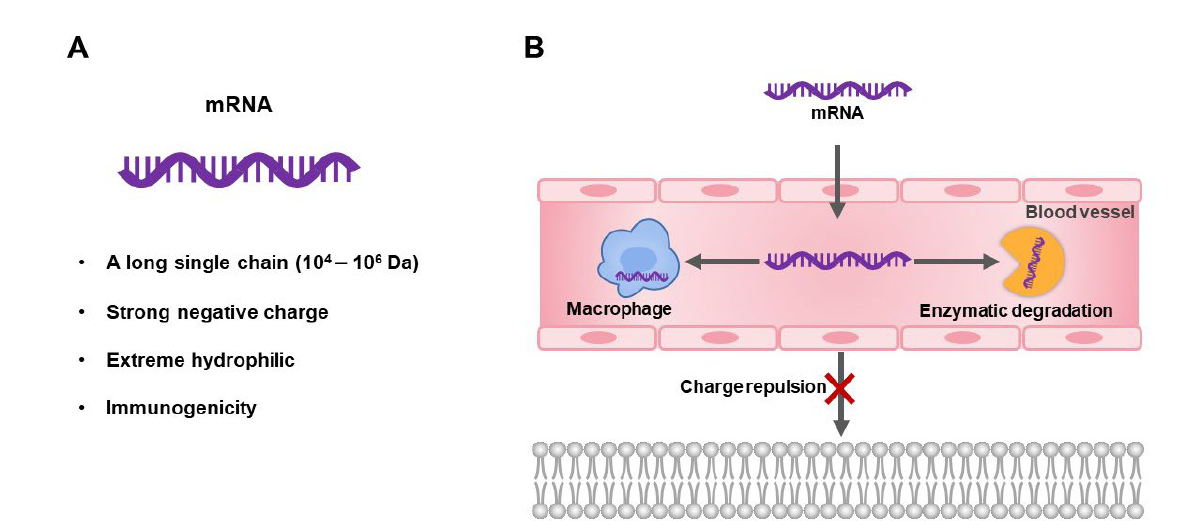
Figure 2. Structural properties and delivery challenges of mRNA therapeutics. A. The structural characteristics of mRNA; B. the schematic diagram of the intracellular and extracellular obstacles that mRNA therapy needs to overcome